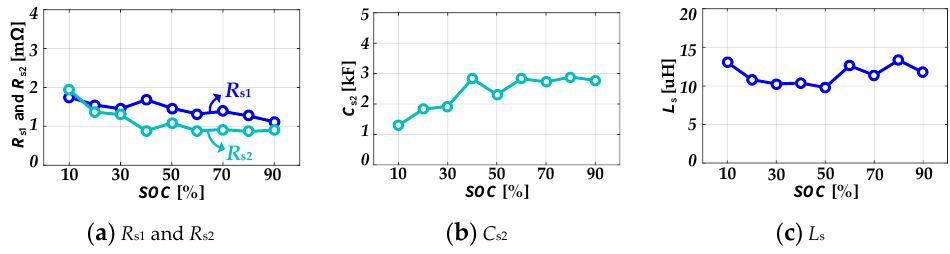
Figure 6. Parameter identification results of proposed model in Figure 4.